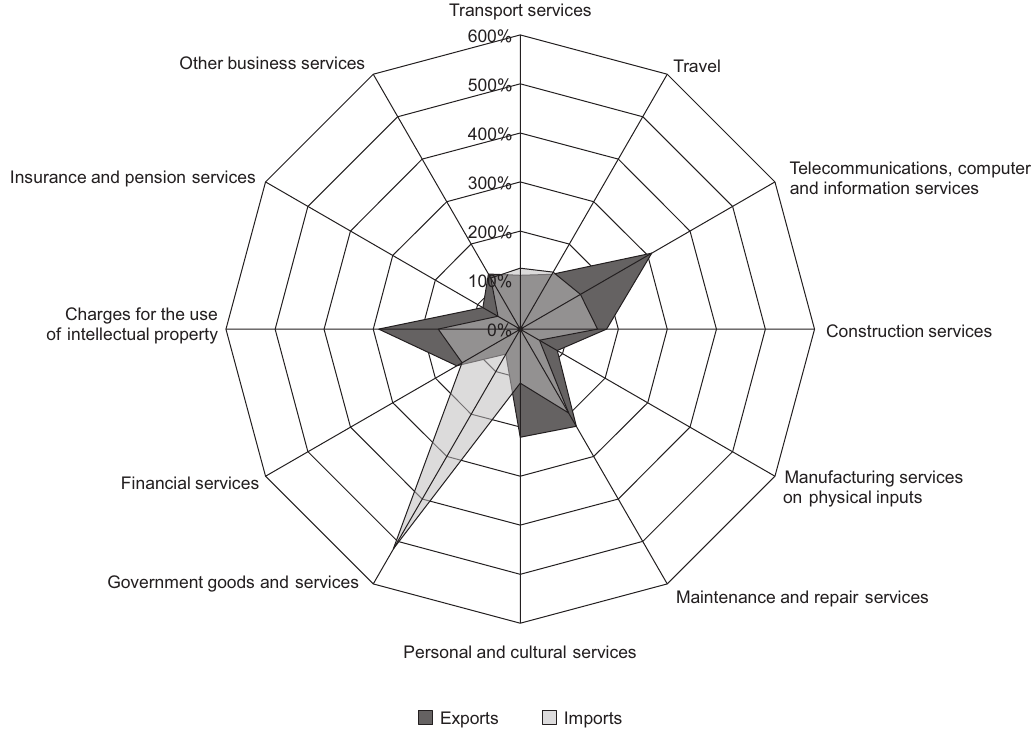
Fig. 2. The growth rates of service exports and imports of the Republic of Belarus in 2018 compared to 2012. Source: own study based on the National Statistical Committee of the Republic of Belarus (2013, 2019).